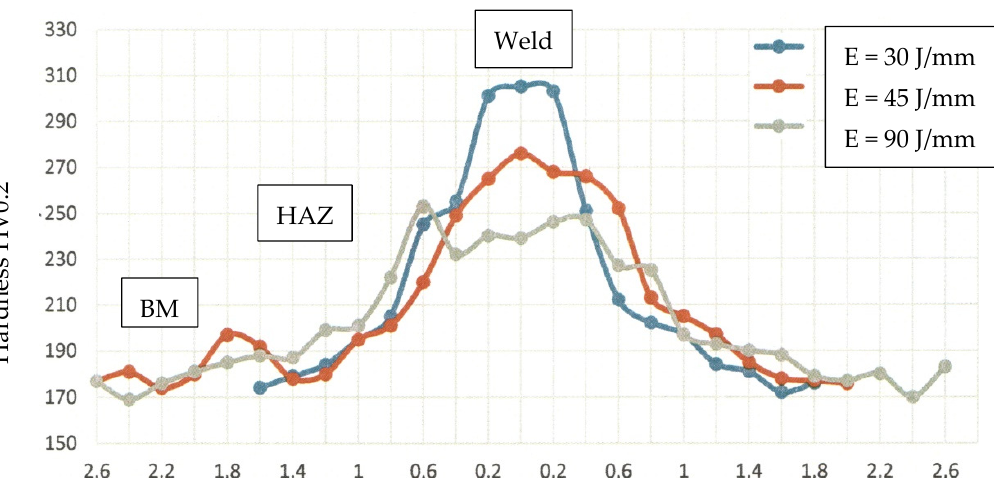
Figure 5. Hardness distribution of welded joints.